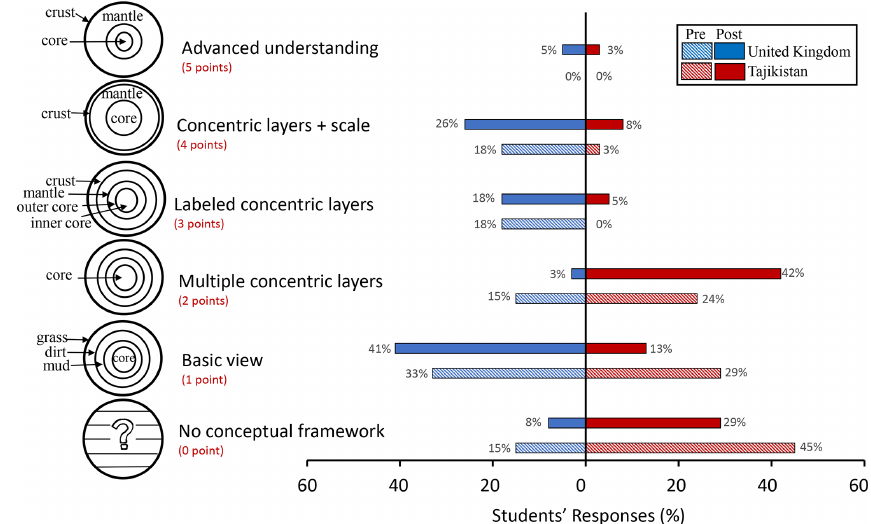
Figure 4. Students’ understanding of Earth’s interior (right) when asked to sketch a cross section of the Earth. The evaluation rubric is after Steer et al., 2005 (left).